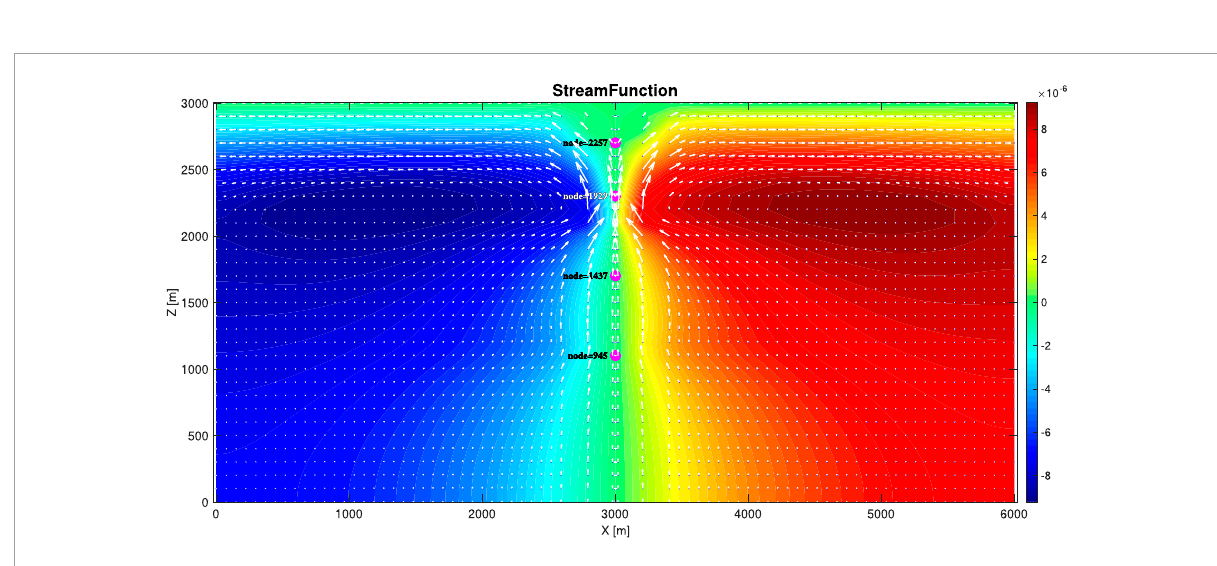
FIGURE 12 Stream function field in the Phlegraean Fields with the DBHE in service (65